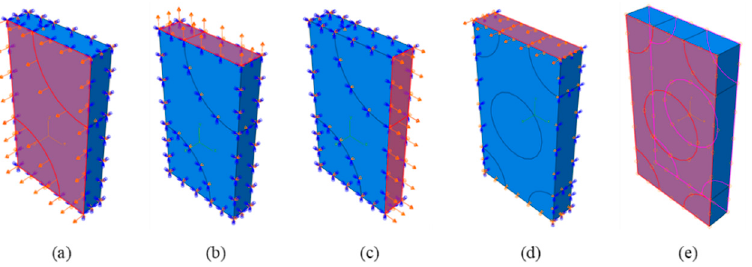
Figure 3. Boundary conditions for unit cell: unit strain in the fiber direction ( a ), unit strain in the transverse directions ( b , c ), unit shear strain along the fiber direction ( d , e ).